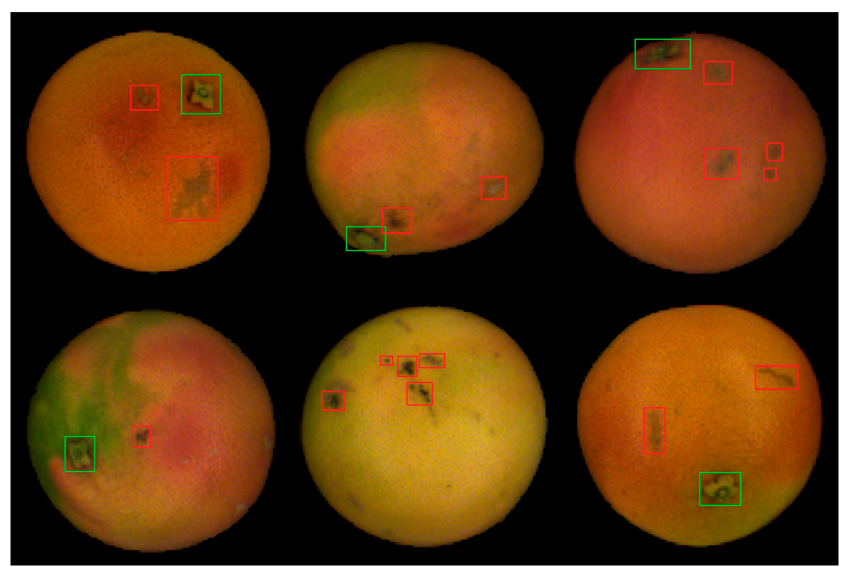
Figure 8. The detection results of HFD on pomelo. The stem end can be detected from black spots. Green and red boxes indicate the stem end and black spots respectively. On our pomelo dataset, HFD achieved mAP of 89.65% at 70.92 FPS with 100.34 M parameters; the mAP is 8.37% greater than DETR, which also has the backbone of Swin Transformer (base). It is competitive with the state-of-the-art transformer-based detectors such as DETR, Deformable DETR, and YOLOS and one-stage detectors such as YOLO v4 and YOLO v5 with high detection accuracy and real-time performance. In particular, the mAP of the stem end of the pomelo reaches 98.23% in HFD-Swin-base, and the mAP of the black spot reaches 81.93%.